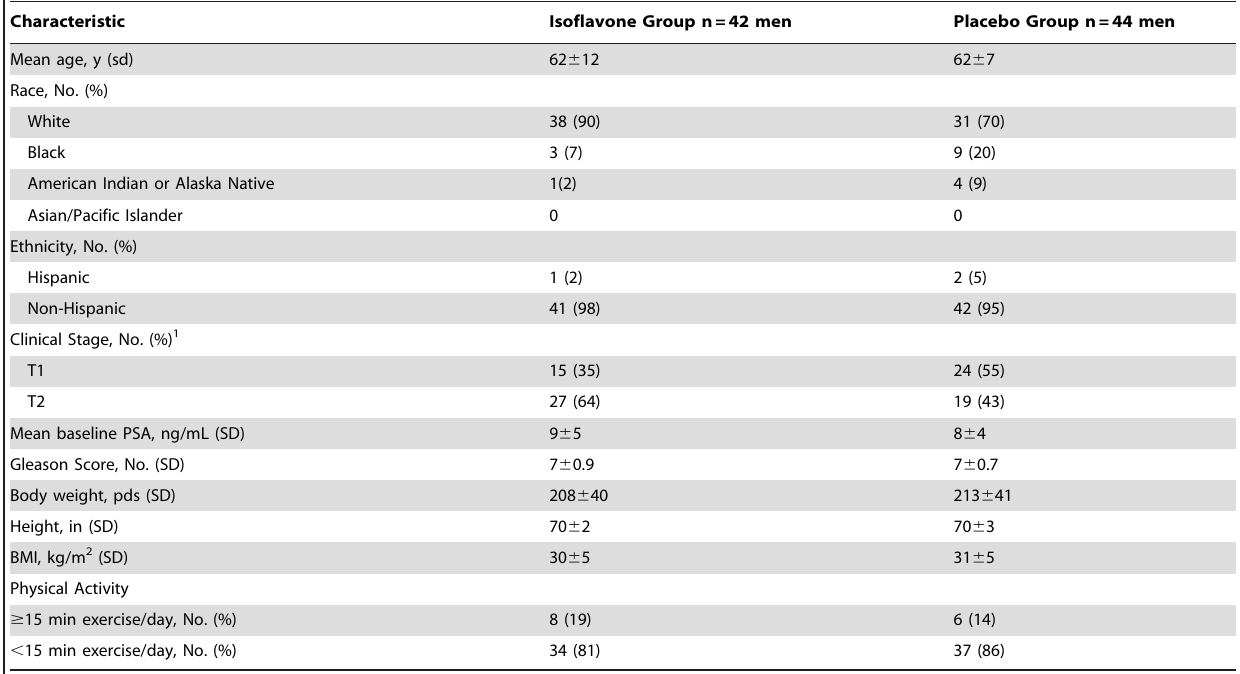
Table 1. Baseline Characteristics of